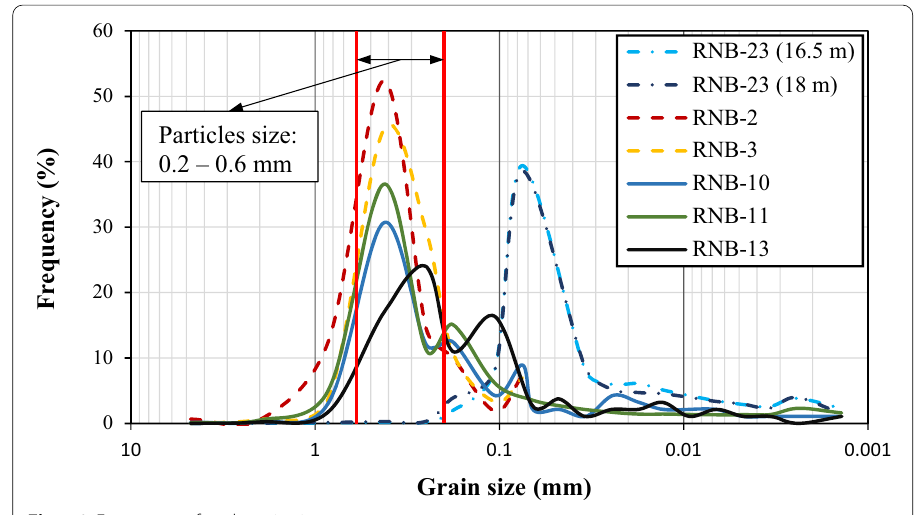
Fig. 16 Frequency of each grain